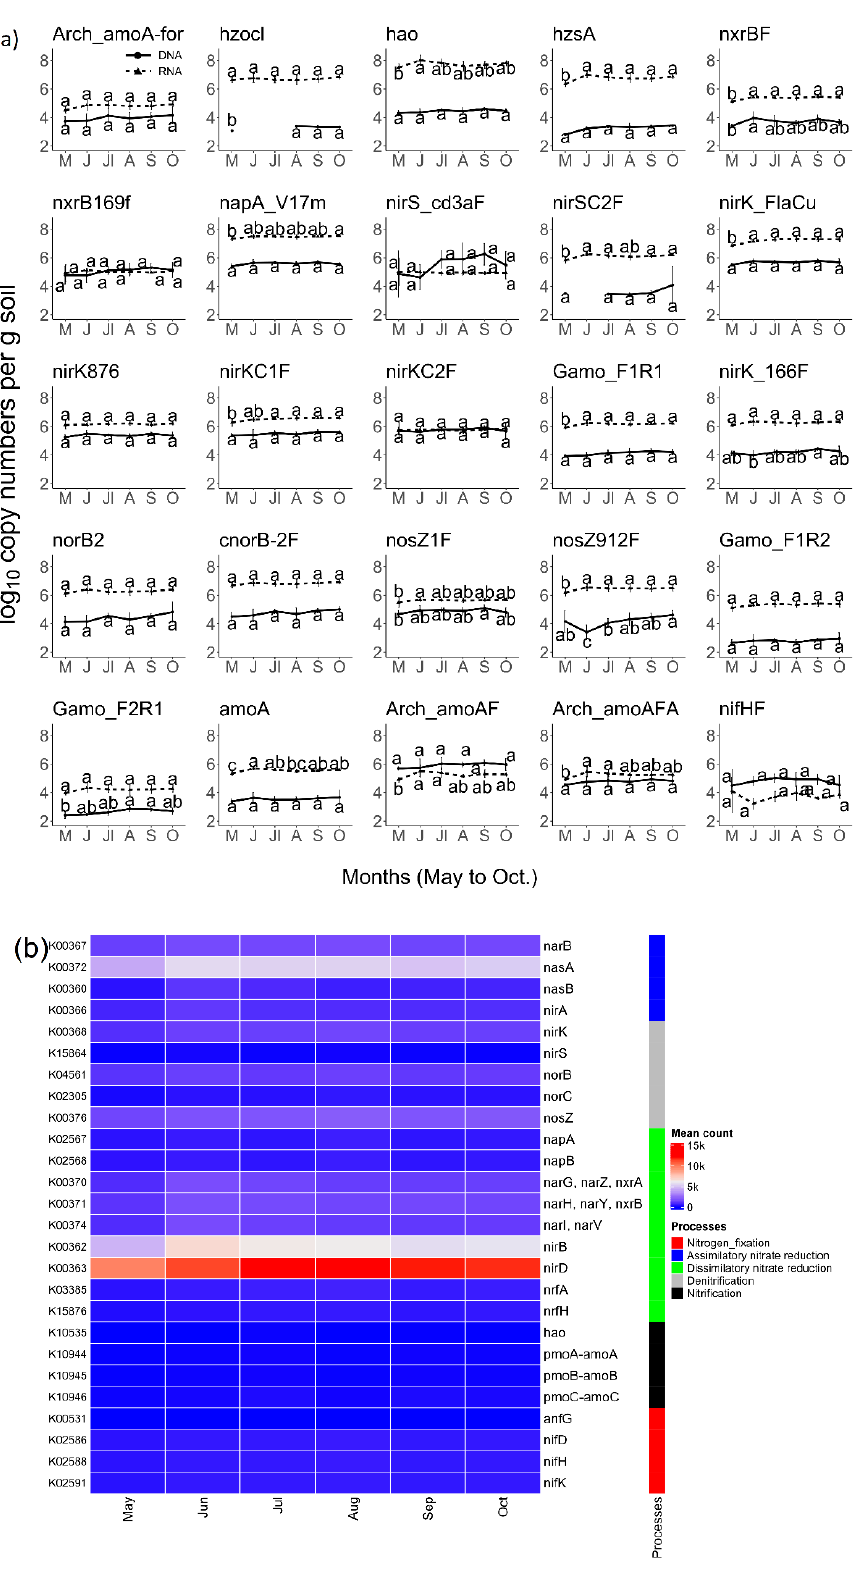
Figure 1. N cycle genes and transcript counts did not change across seasons. ( a ) Copy numbers of nitrogen cycle gene and gene expression levels across the growing season determined using the NiCE chip and expressed as log10. Letters on the line graph represent groups from Tukey HSD test [ANOVA, p < 0.05]; ( b ) heatmap of selected orthologs associated with nitrogen cycle, derived from PICRUSt2